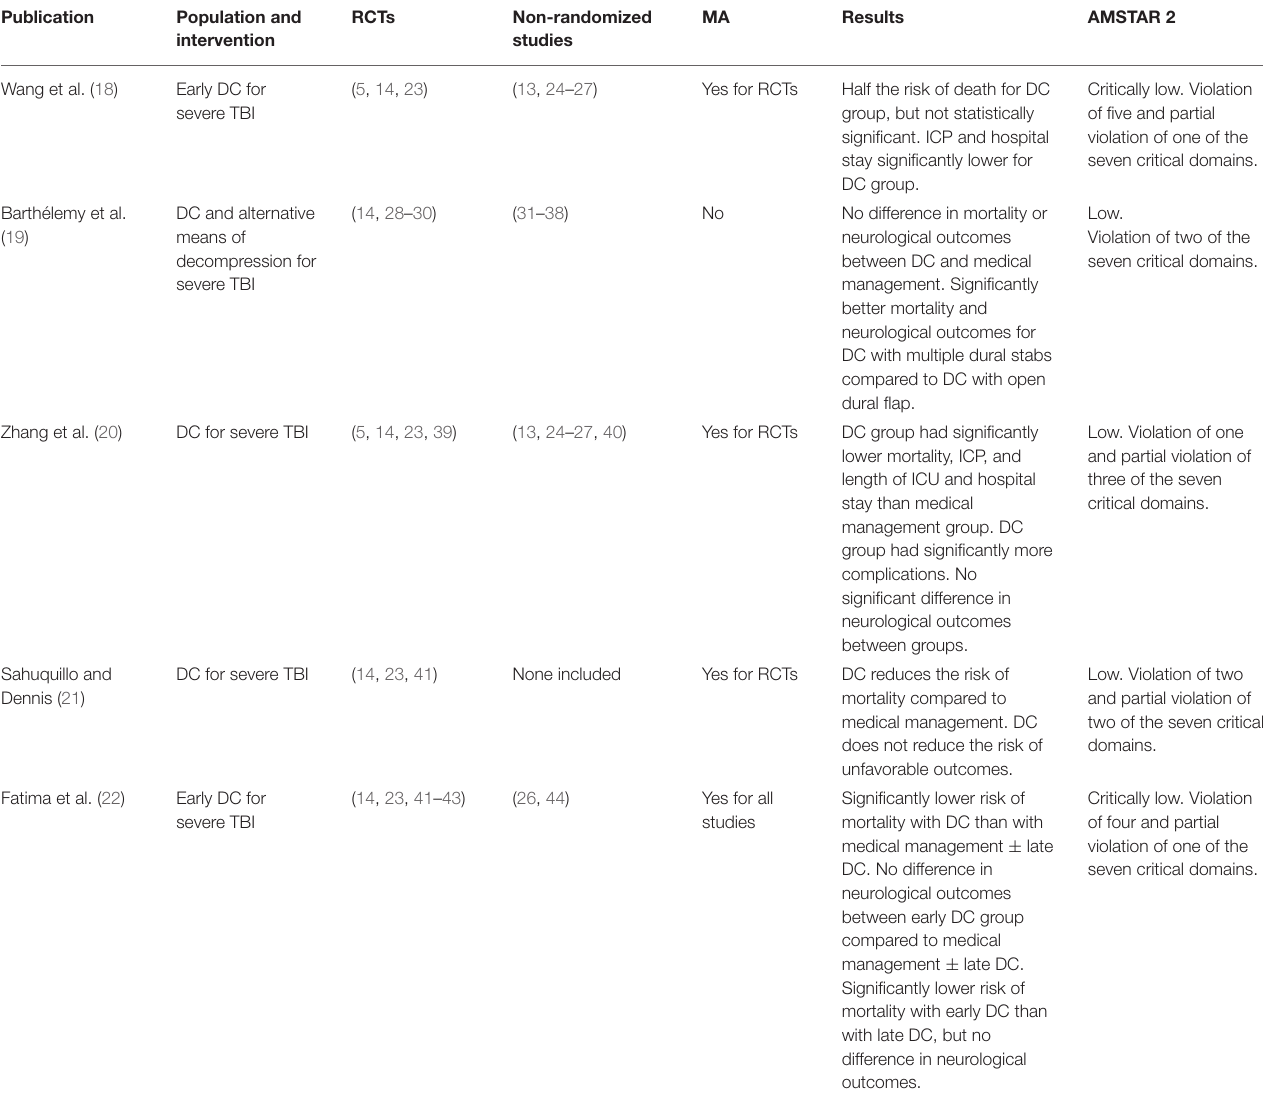
TABLE 1 | Summary of systematic reviews/meta-analyses about decompressive